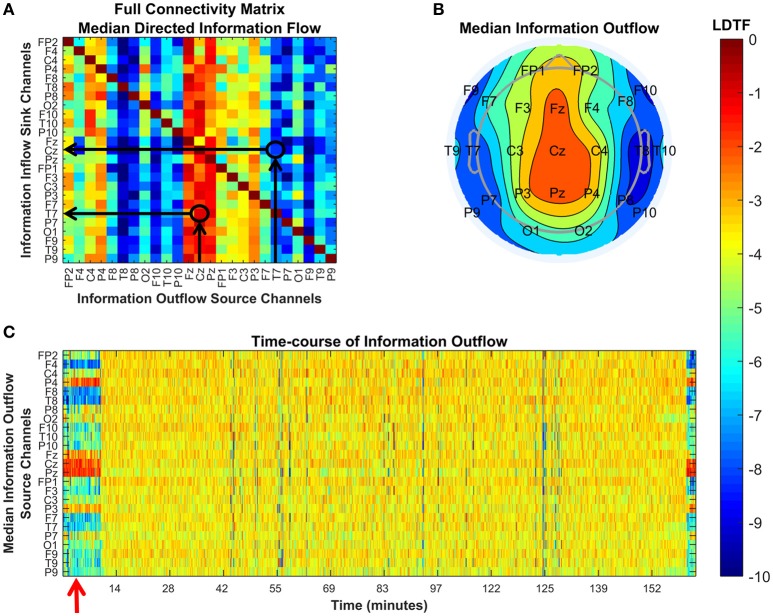
Explanations of the plots used to visualize the DTF analysis. Each panel shows different properties of the connectivity as quantified by the DTF in our analysis. (A) Visualization of the full connectivity matrix within a given frequency range (here 8–12 Hz) for a specific 1-s segment from a given patient (#6). Each element in this matrix represents the median LDTF from a given source channel (x-axis) to a given sink channel (y-axis), and the strength is given by the color (color bar, right). Two examples are indicated by black arrows and circles in the matrix, showing the relatively strong (red) information flow from Cz to T7, and the relatively weak (blue) information flow in the opposite direction, from T7 to Cz. (B) Topographical representation of the source channels' strengths of information outflow from the same 1-s segment presented in (A). The positons of channel labels indicate their relative locations on the head as seen from above (nose pointing up). In this 1-s segment, the medial channels are strong, whilst more lateral channels are weaker, sources of information outflow. (C) Shows how each channel's strength of information outflow changes with time (x-axis). Red arrows mark important points. Here, it marks the time of the 1-s segment visualized in the figures in (A,B). All figures use the same color scale, shown by the color bar.